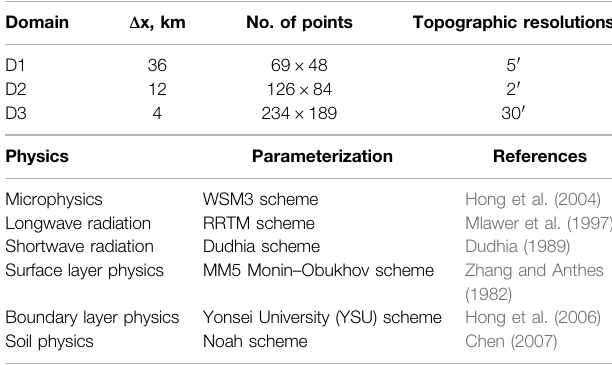
TABLE 1 | Domain con fi guration and parameterization schemes selected for the weather research and forecasting model.